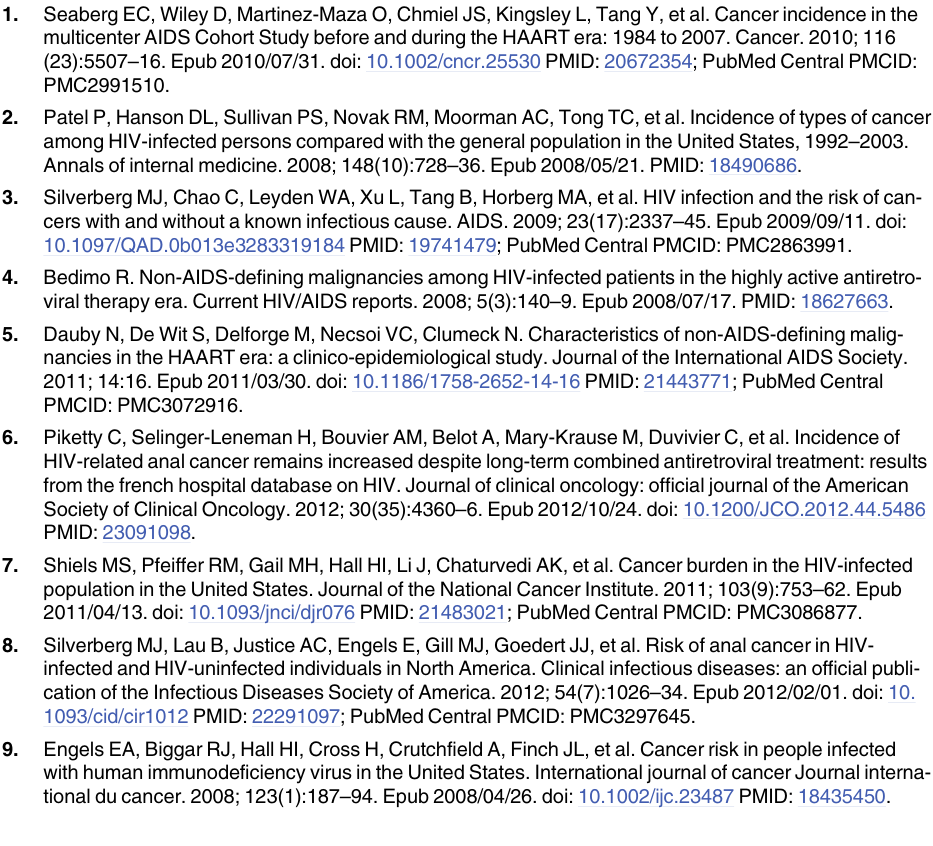
S1 Table. Median follow-up times in years for participants with and without squamous